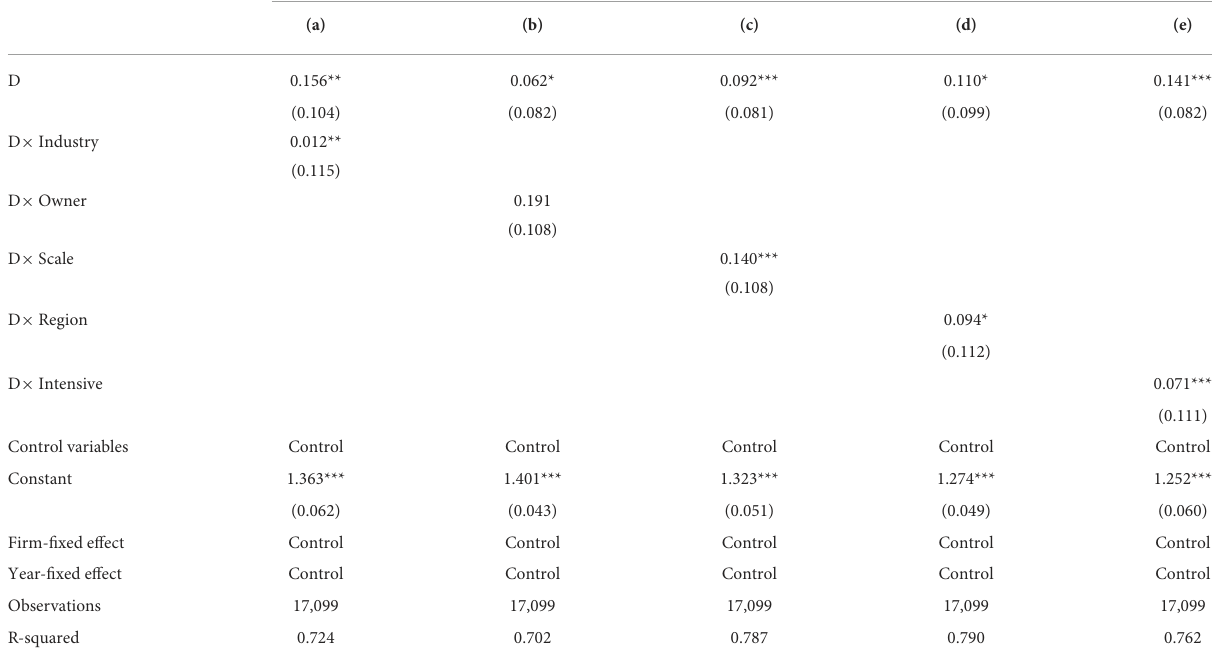
TABLE 8 Results of heterogeneity